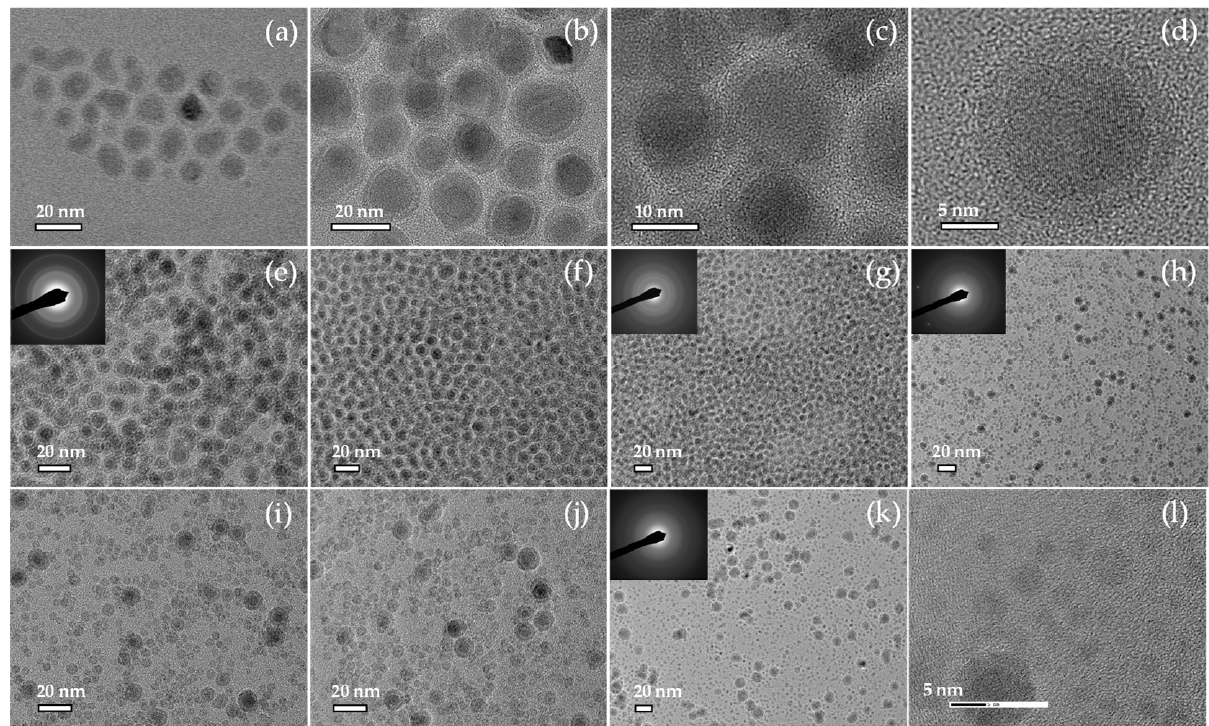
Figure 1. TEM images from Fe/Fe 3 O 4 core-shell nanoparticles synthesized by hot injection at 315 °C ( a ), 285 °C ( b – d ), 260 °C ( e ), 240 °C ( f ), 220 °C ( g ), 200 °C ( h – j ), and 180 °C ( k , l ). Summarized data for the size distribution histograms were presented in Table S1.